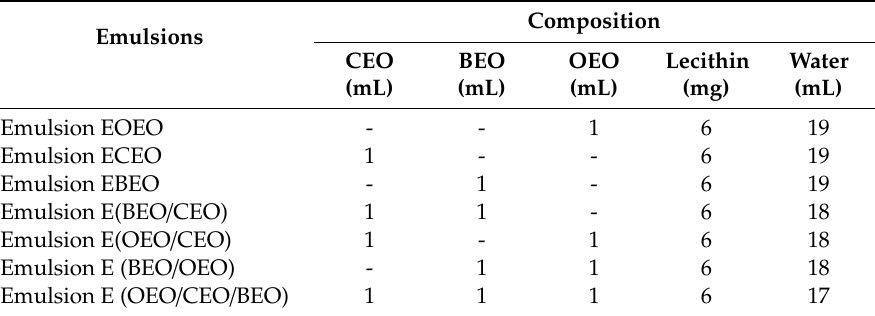
Table 1. The composition of natural